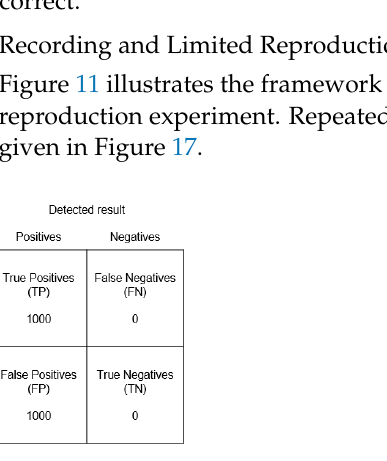
Figure 17. Recording and limited reproduction confusion matrix.